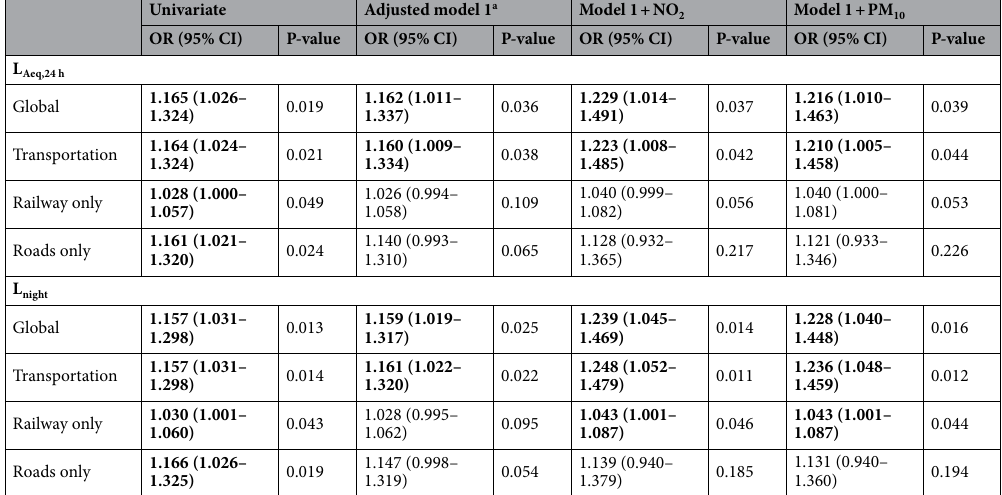
Table 2. Associations between noise exposure and risk categories of TRS-2P score. Odds ratios associated to noise exposure expressed for an increase of 10 dB(A). OR odds ratio, CI confidence interval. Significant values are in bold. a Model 1: Model adjusted on sex, socio-economic level and heart rate.